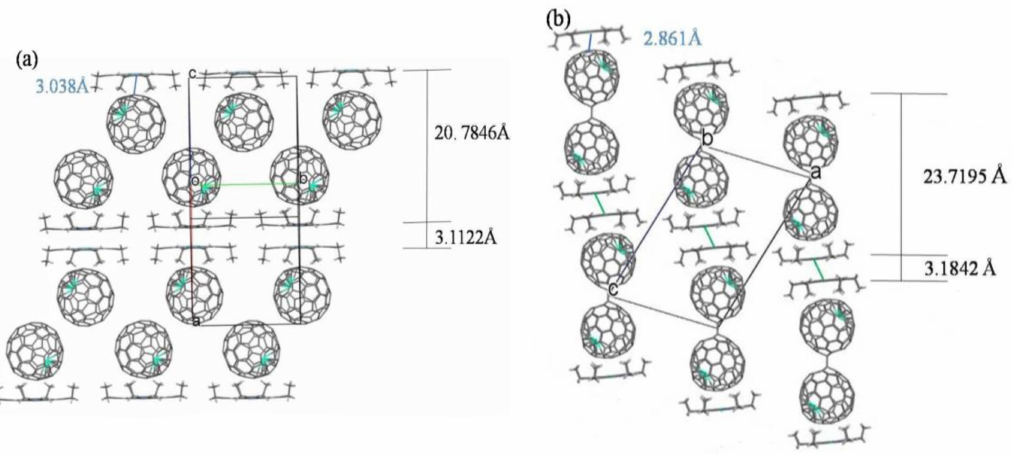
Figure 6. The packing structures of ( a ) Tb@C 2v (9)-C 82 and ( b ) Tb@C S (6)-C 82 in their cocrystals with Ni(OEP). Only one cage orientation and the major terbium site are illustrated, with solvent molecules omitted for clarity.